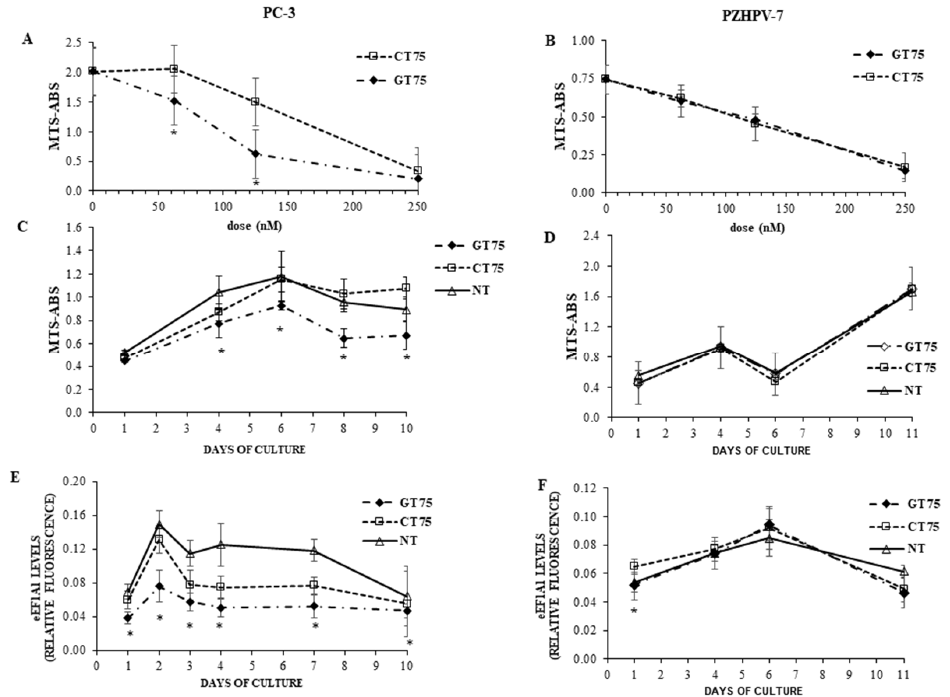
Figure 3. Effects of eEF1A1 targeting by GT75 on cell viability and protein level in PC-3 and PZHPV-7. ( A , B ) Dose-dependent effect of the GT75 aptamer and of the control CT75 on cell viability in PC-3 ( A ) and PZHPV-7 ( B ) cell lines evaluated by MTS assay 10 days after aptamer transfection. ( C , D ) Time-dependent effect of GT75 (150 nM) and CT75 (150 nM) on cell viability evaluated by MTS assay. ( E , F ) eEF1A1 protein levels, in PC-3 and PZHPV-7 cell lines following GT75 (150 nM) or CT75 (150 nM) transfection. eEF1A1 protein levels expressed as fluorescence arbitrary units, have been quantified by in-cell Western assays. * p < 0.05 compared with CT75-treated cells; data are shown as the mean ± SD, n = 8.